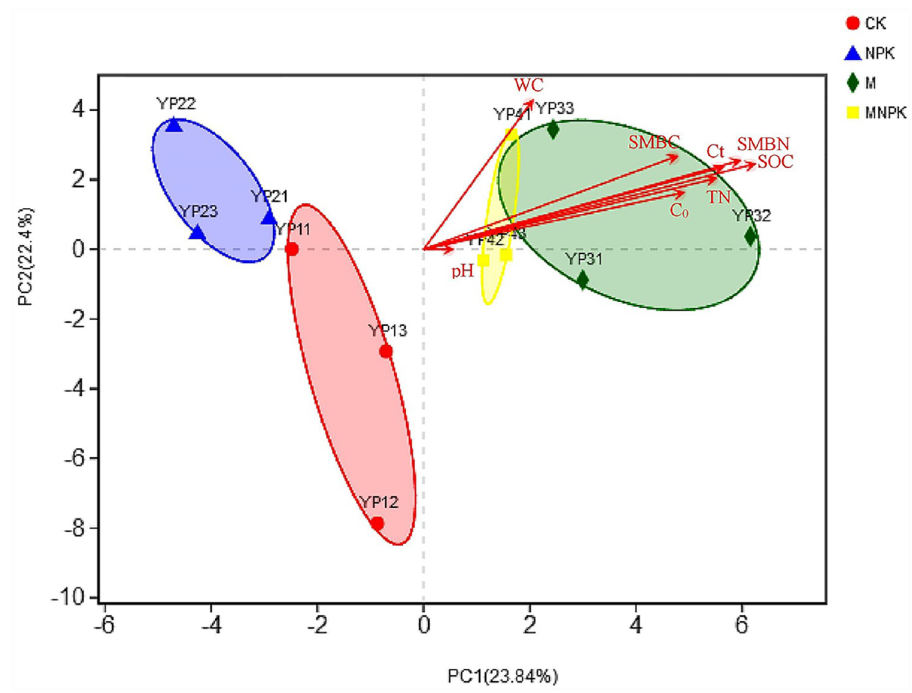
Fig 4. Principal component analysis of bacterial community composition and environmental factors on the Phylum